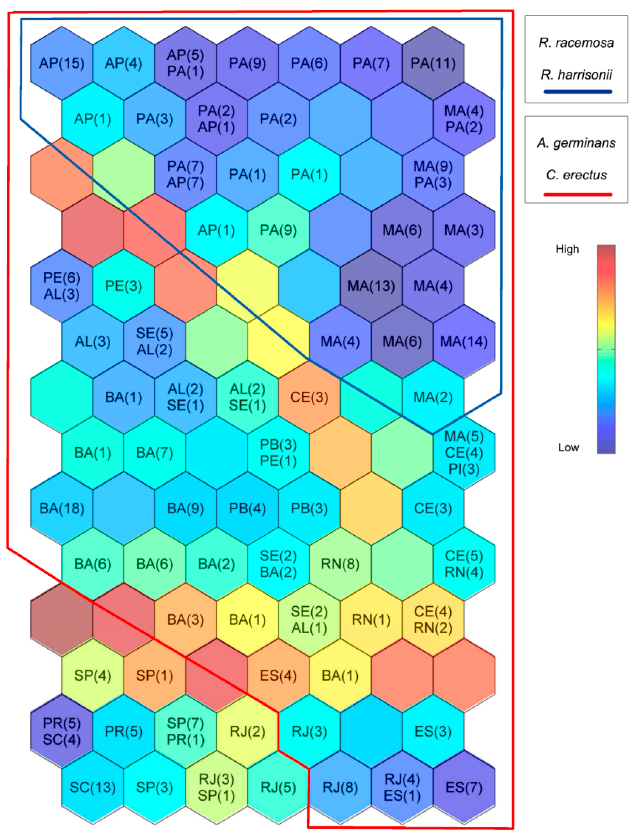
Figure 3. SOM Component planes. The component planes organized in three groups according to correlated components. High values are in red, intermediated values in yellow and green, and low values in dark blue.